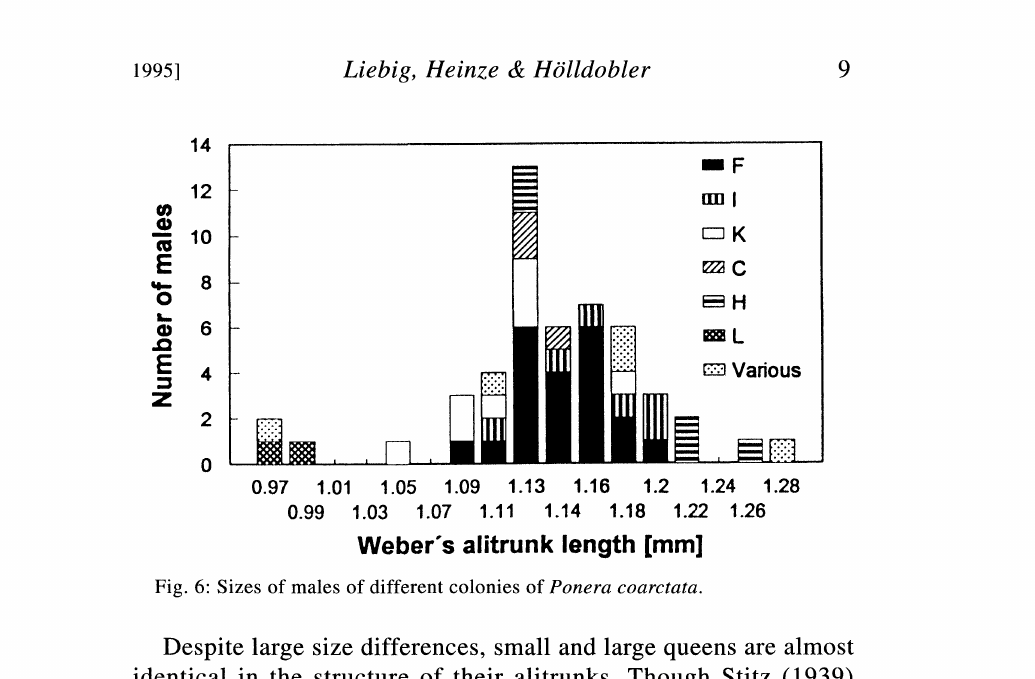
Fig. 6: Sizes of males of different colonies of Ponera coarctata. Despite large size differences, small and large queens are almost identical in the structure of their alitrunks. Though Stitz (1939) mentioned ergatoid queens in P. coarctata, all queens in our sam- ple had a complete set of thoracic sclerites and bore wing rem- nants. Similar queen size variation is known in Myrmica ruginodis (Brian and Brian, 1949; Elmes, 1991) and Pseudomyrmex venefica (Janzen, 1973). In Polyrhachis cf. doddi size variation is associ- ated with a more or less allometric reduction in scutum size (Heinze and H611dobler, 1993). The size distribution of P. coarc- rata queens is continuous rather than bimodal. It is therefore not useful to refer to distinct queen morphs (macro- and microgynes) in this species, as was done by Stitz (1939) and is common usage in the Myrmica literature. Queens reared within a single colony typically differ less markedly from each other than queens taken at random from the population, though colonies apparently do not specialize in pro- ducing only small or only large queens. Whether size variation is caused by genetical or environmental factors is not known. In two queen-polymorphic leptothoracines, Harpagoxenus sublaevis and Leptothorax sp. A, the queen morph is genetically determined, but environmental or social control appears more likely in this species (Buschinger and Heinze, 1992). Some of the smallest queens of